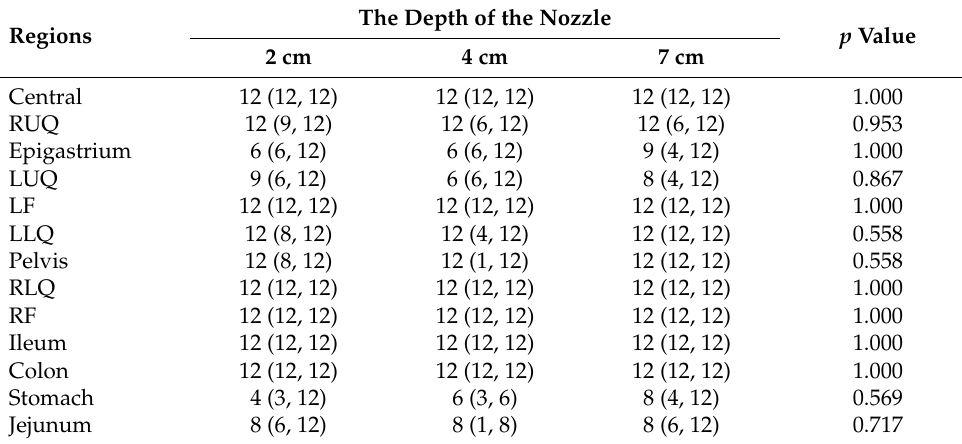
Table 1. Comparison of the distribution of 1% methylene blue among 2, 4, and 7 cm depth of the nozzle in 13 regions of pigs’ abdomen.